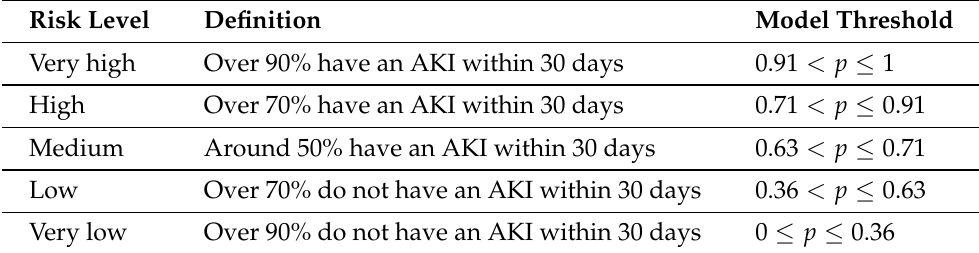
Table 2. Mapping model probabilities to risk levels. Predictions from the trained random